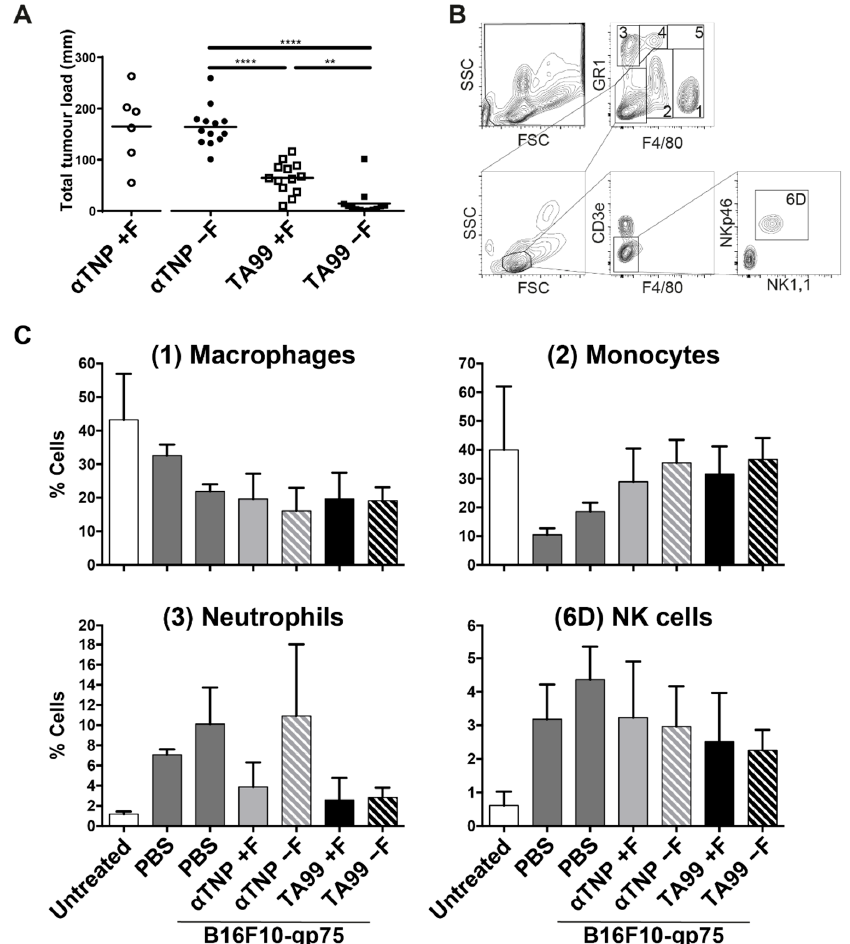
Figure 3. Treatment with afucosylated jIgG1-TA99 decreased tumor outgrowth in vivo. ( A )